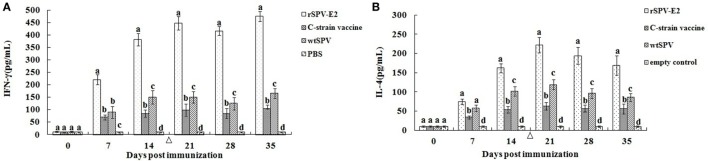
The immune response to rSPV-E2 following vaccination (n = 5). The type of immune response induced by rSPV-E2 was indirectly assessed by measuring serum levels of IFN-γ and IL-4 by the ELISA kit. (A) The concentration of serum IFN-γ of pigs in different groups postimmunization. (B) The concentration of serum IL-4 of pigs in different groups postimmunization. Different letters (a–d) indicate significant difference (P < 0.05) between groups. Δ Indicate the time point (14 dpi) of boost of pigs.